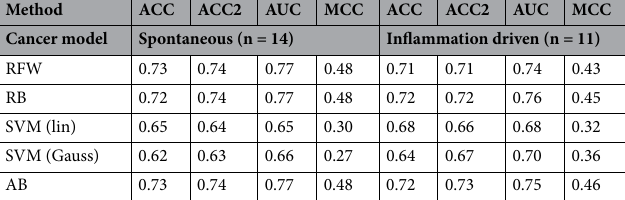
Table 4. Classification results of the tested classifiers for the spontaneous cancer model (left) for 14 mice and the inflammation driven cancer model (right) for 11 mice.